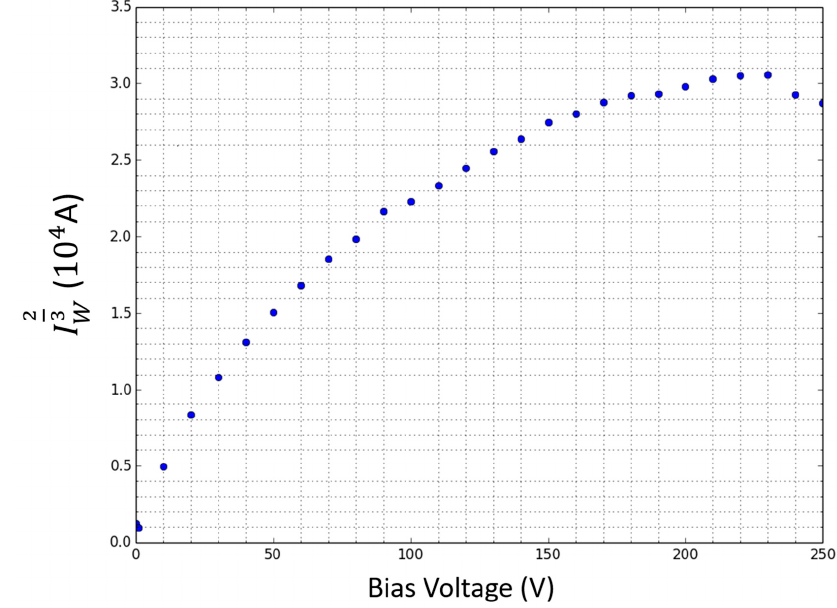
Figure 4. Curve of measured thermionic current versus increased bias voltage (difference between collectors and filament). In this case, the critical voltage observed was around 200 V and, after that, the collected current started plateauing. If measurements were taken at a voltage before the plateau, not all electrons would be collected for some temperatures of the filament, which would indicate a lower pressure. The current was manipulated as the y -axis indicates to be in the same form as Figure 21 in the Taylor and Langmuir paper